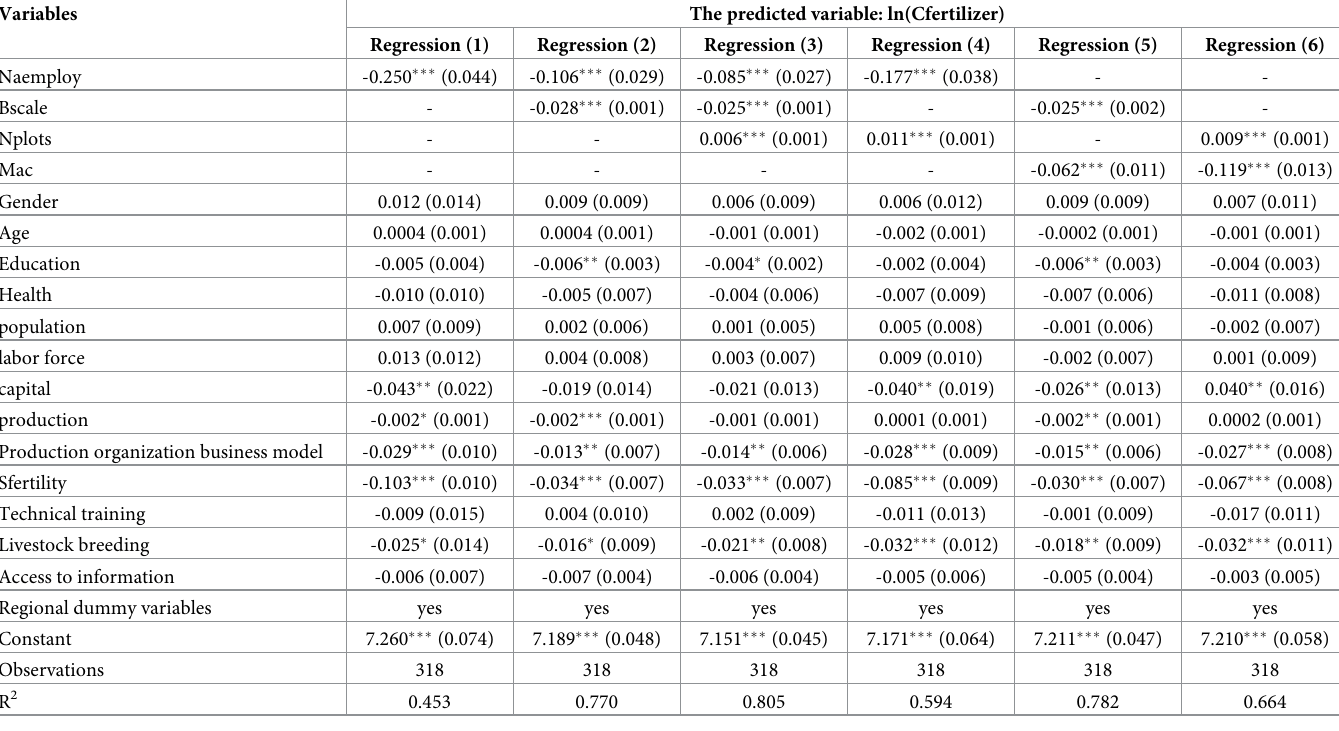
Table 3. Model estimation results of influencing factors of CF application intensity of sample farmers (excluding interactive items). Variables